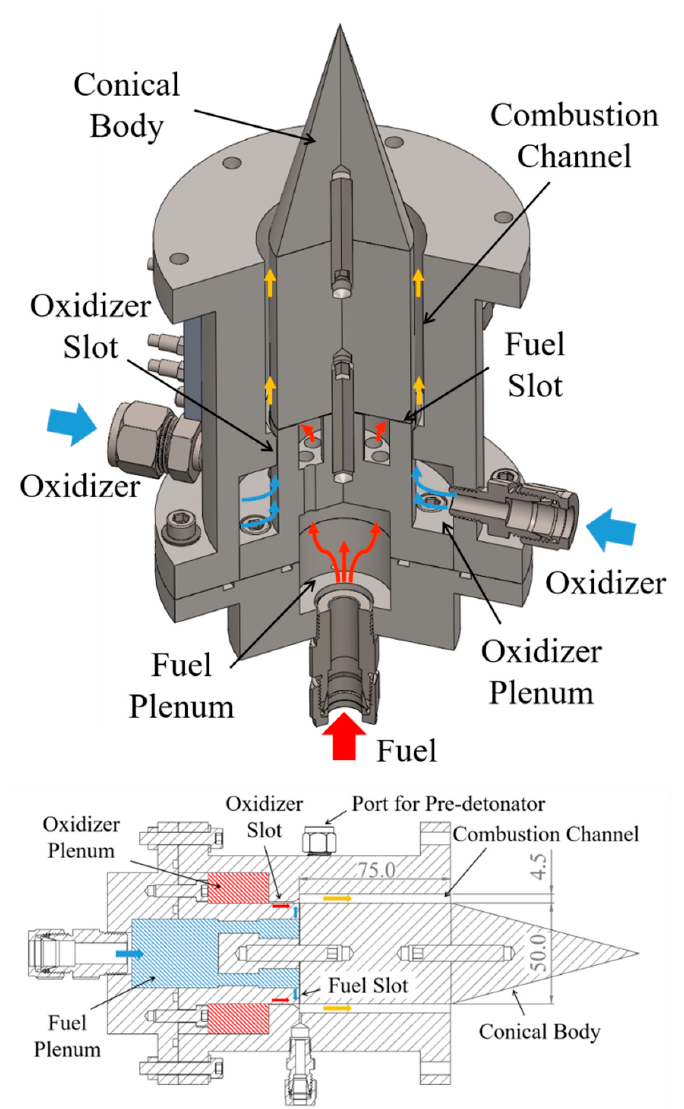
Figure 2. Configuration of RDE model (unit: mm).